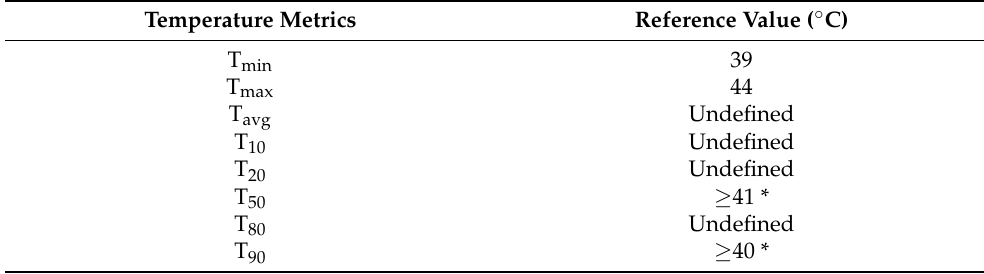
Table 2. Reference temperature metrics.